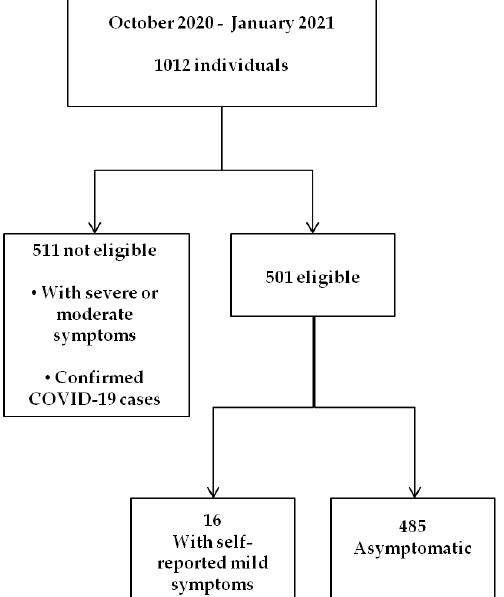
Figure 1. Flow chart summarizing the study design. Over a period of four months, 1012 individuals were tested for SARS-CoV-2 infection. Eligible patients for the comparative study were 501 individuals declaring mild or no COVID-19 related symptoms and not previously diagnosed as COVID-19-cases.